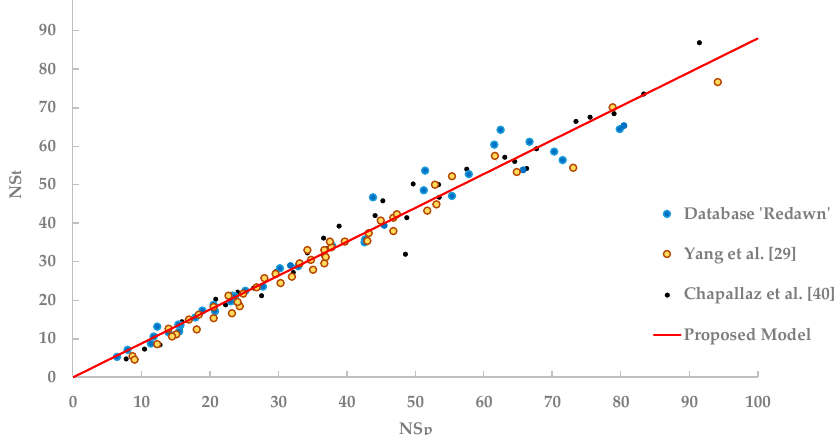
Figure 1. Comparison of all available experimental points in the literature and the experimental data of database Redawn.